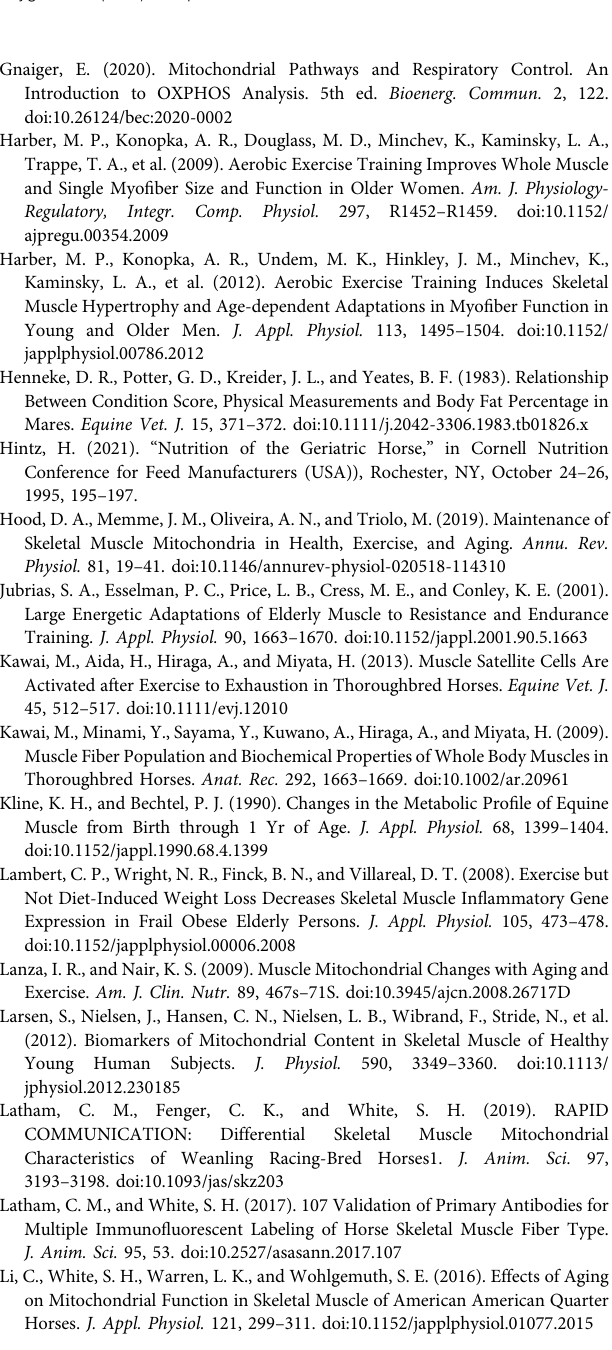
malate (1 mM) to support electron fl ow through complex I (CI) of the electron transfer system (ETS; LEAK respiration); 2) adenosine diphosphate (ADP; 2.5 mM) to stimulate respiration (OXPHOS) and cytochrome c (cyt c; 10 μ M) to assess outer mitochondrial membrane integrity; 3) glutamate (10 mM) as an additional CI substrate to assess OXPHOS with complex I (PCI); 4) succinate (10 mM) to support convergent electron fl ow through complex II (CII) of the ETS (PCI+II); 5) uncoupler carbonyl cyanide 3-chlorophenylhydrazone (CCCP; 0.5 μ M steps) to assess maximal noncoupled ETS capacity (ECI+II); 6) rotenone (0.5 μ M), an inhibitor of complex I, to measure ETS capacity of complex II alone (ECII);